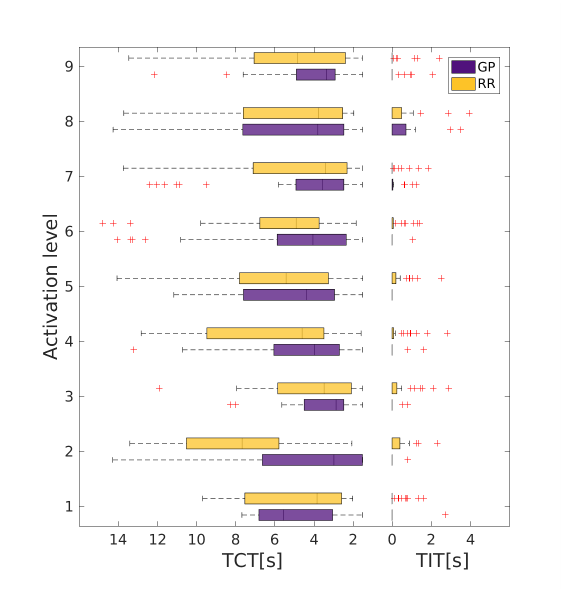
Figure A2. Comparison of the time to complete task (TCT) and the time in the target (TIT) between Gaussian process regression (GPR) and ridge regression (RR), in the case of successful and failed tasks, for each participant.